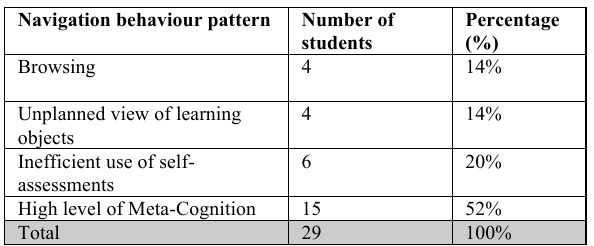
TABLE III. N AVIGATION BEHAVIOUR PATTERNS